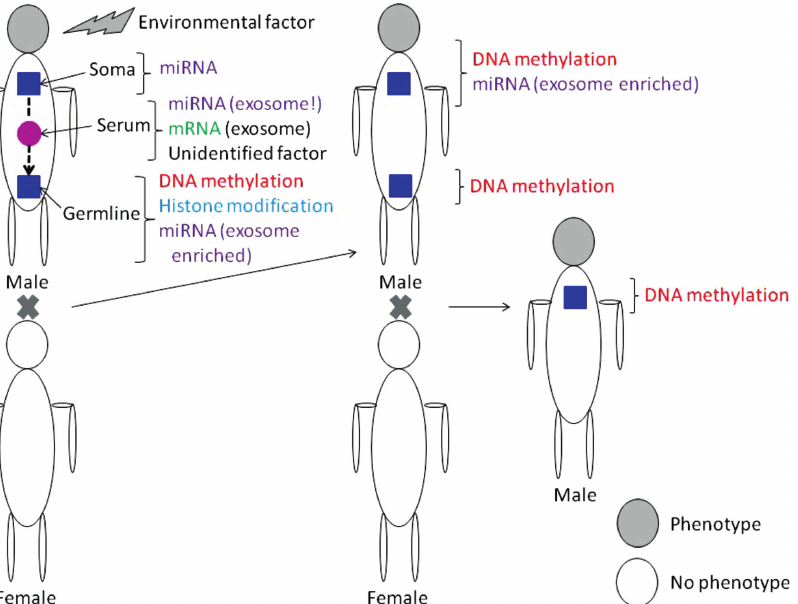
Figure 2: Soma to germline communication. Combined evidence supporting information transfer from somatic cells to germ cells in transgenerational inheritance. Note that circulating exosomal miRNA is the potential